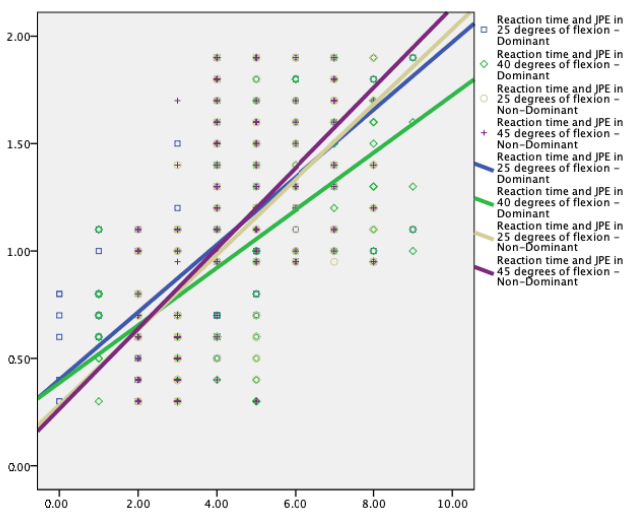
Figure 5. Relationship between Reaction time (s) and knee joint position error at 25 ◦ and 40 ◦ flexion in dominant and nondominant legs.